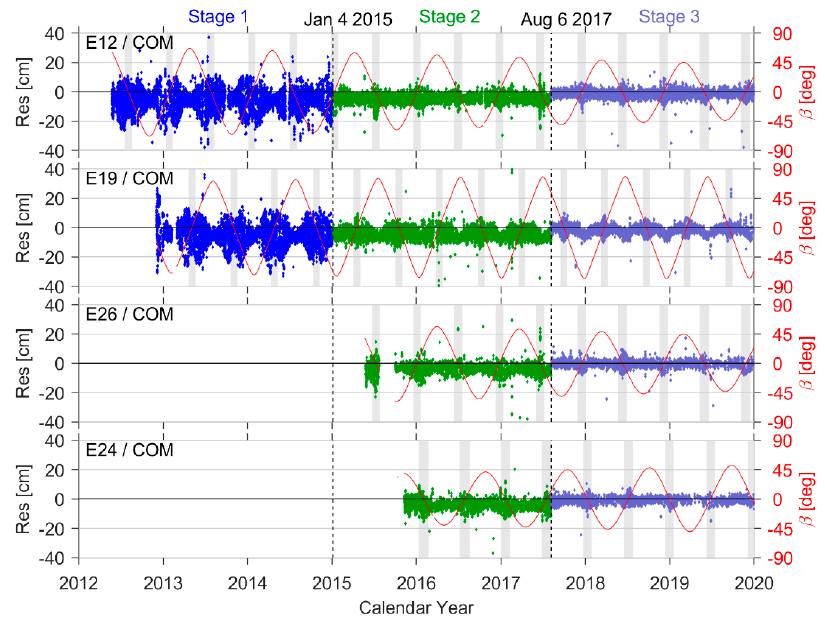
Figure 6. SLR residuals for COM orbits. The red curve represents changes in the Sun elevation angle ( β ) over time, with the grey area indicating the eclipse season.